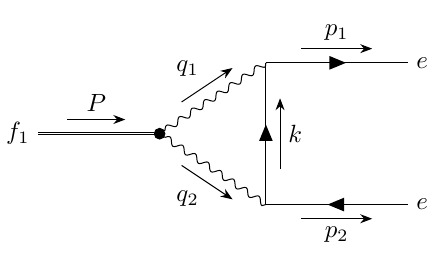
Figure 9 . Feynman diagram for the decay of the axial-vector meson f 1 into an electron- positron